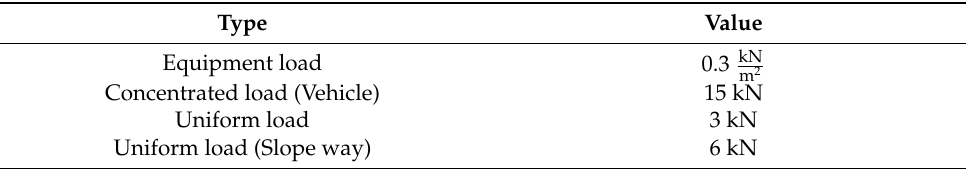
Table 5. Loads for analysis (Campus building